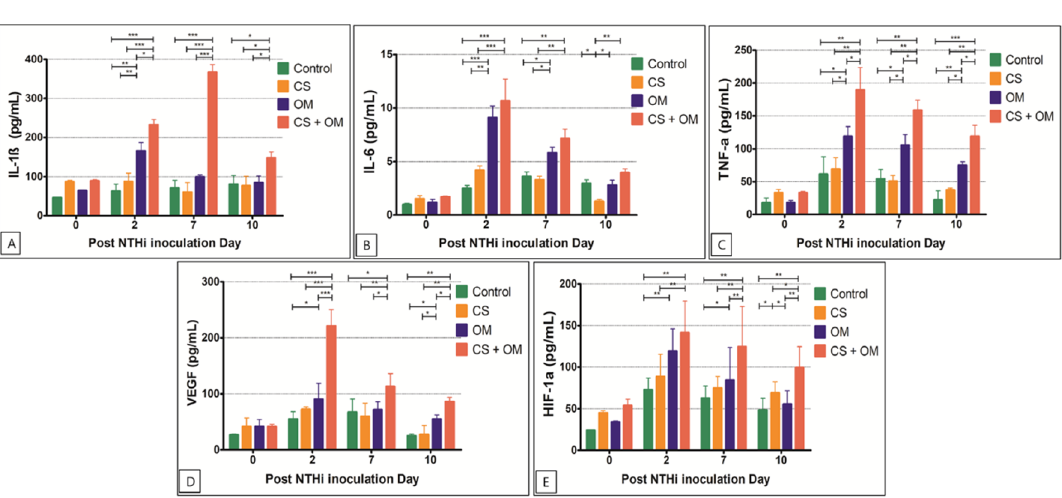
Figure 4. Cytokine profiles of interleukin (IL)-1ß ( A ), IL-6 ( B ), tumor necrosis factor (TNF)-α ( C ), vascular endothelial growth factor (VEGF) ( D ), and hypoxia-inducible factor (HIF)-1α ( E ) in the middle ear mucosa at various time points after non-typeable Haemophilus influenzae (NTHi)